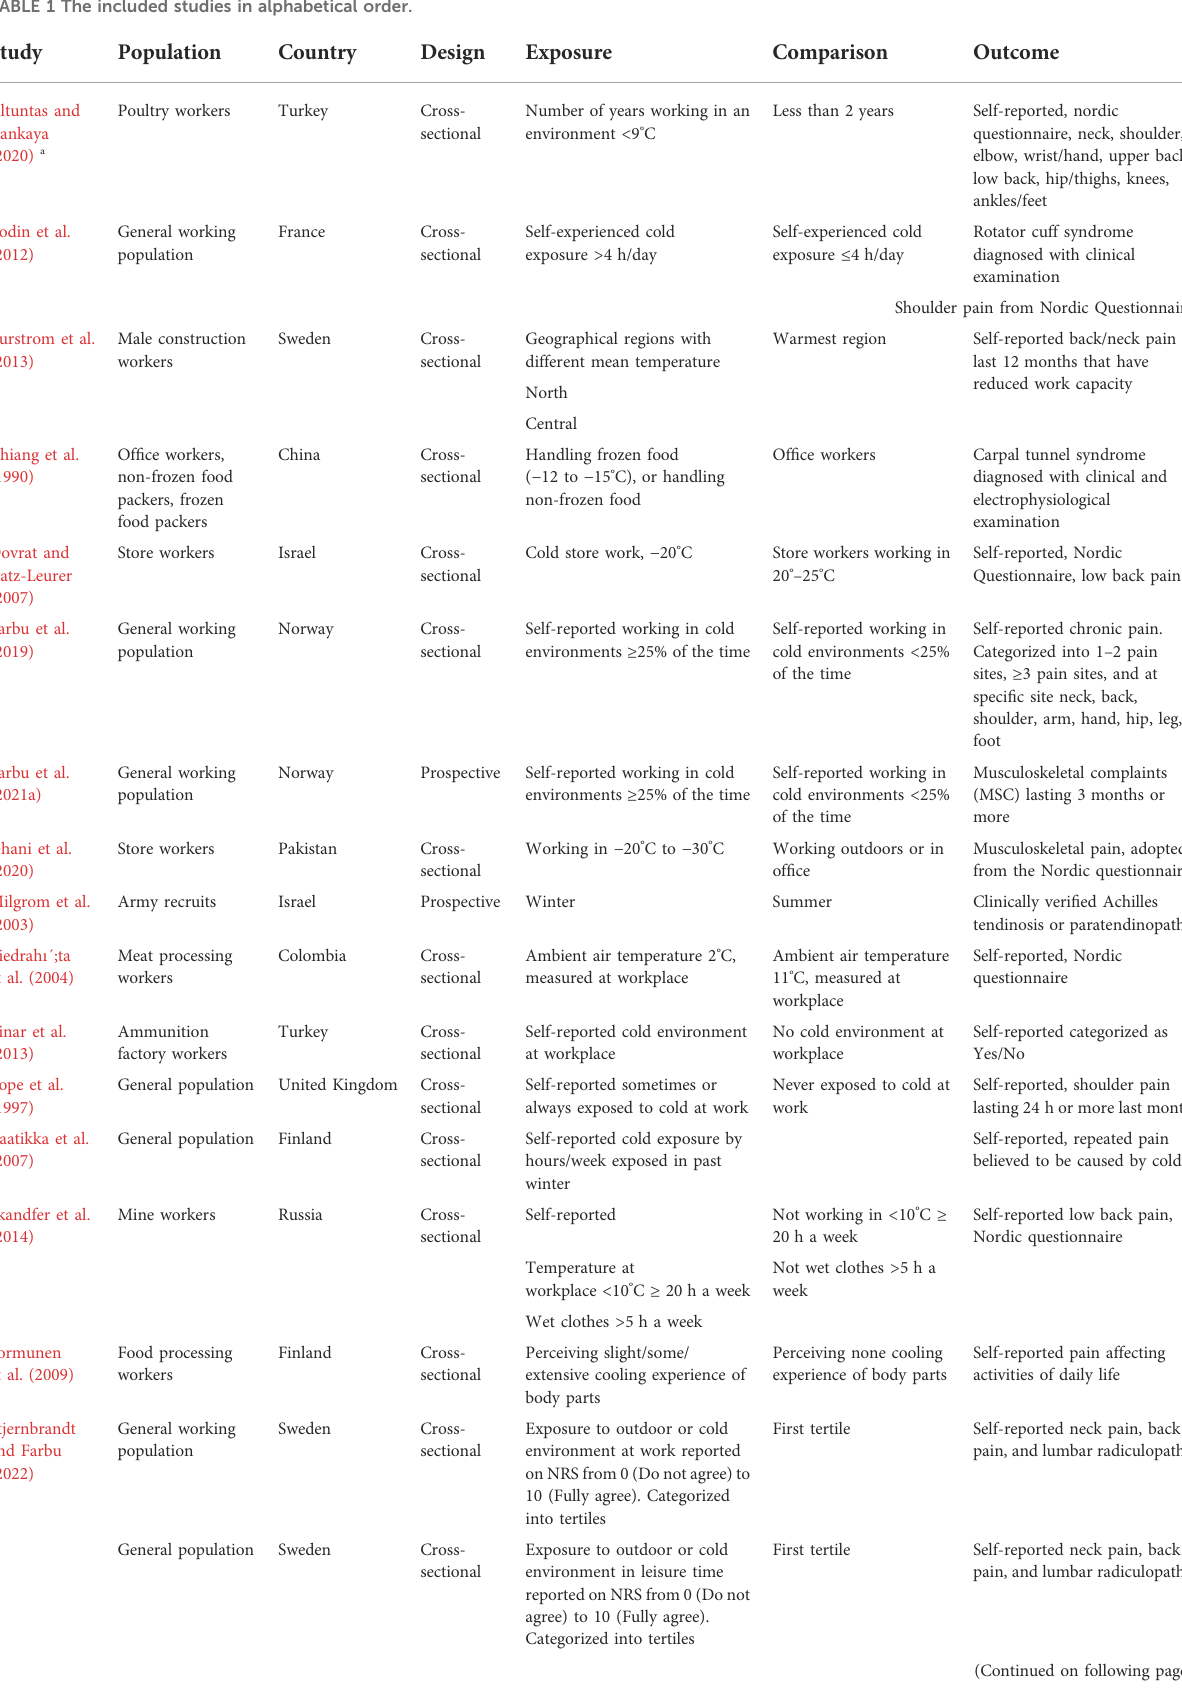
TABLE 1 The included studies in alphabetical